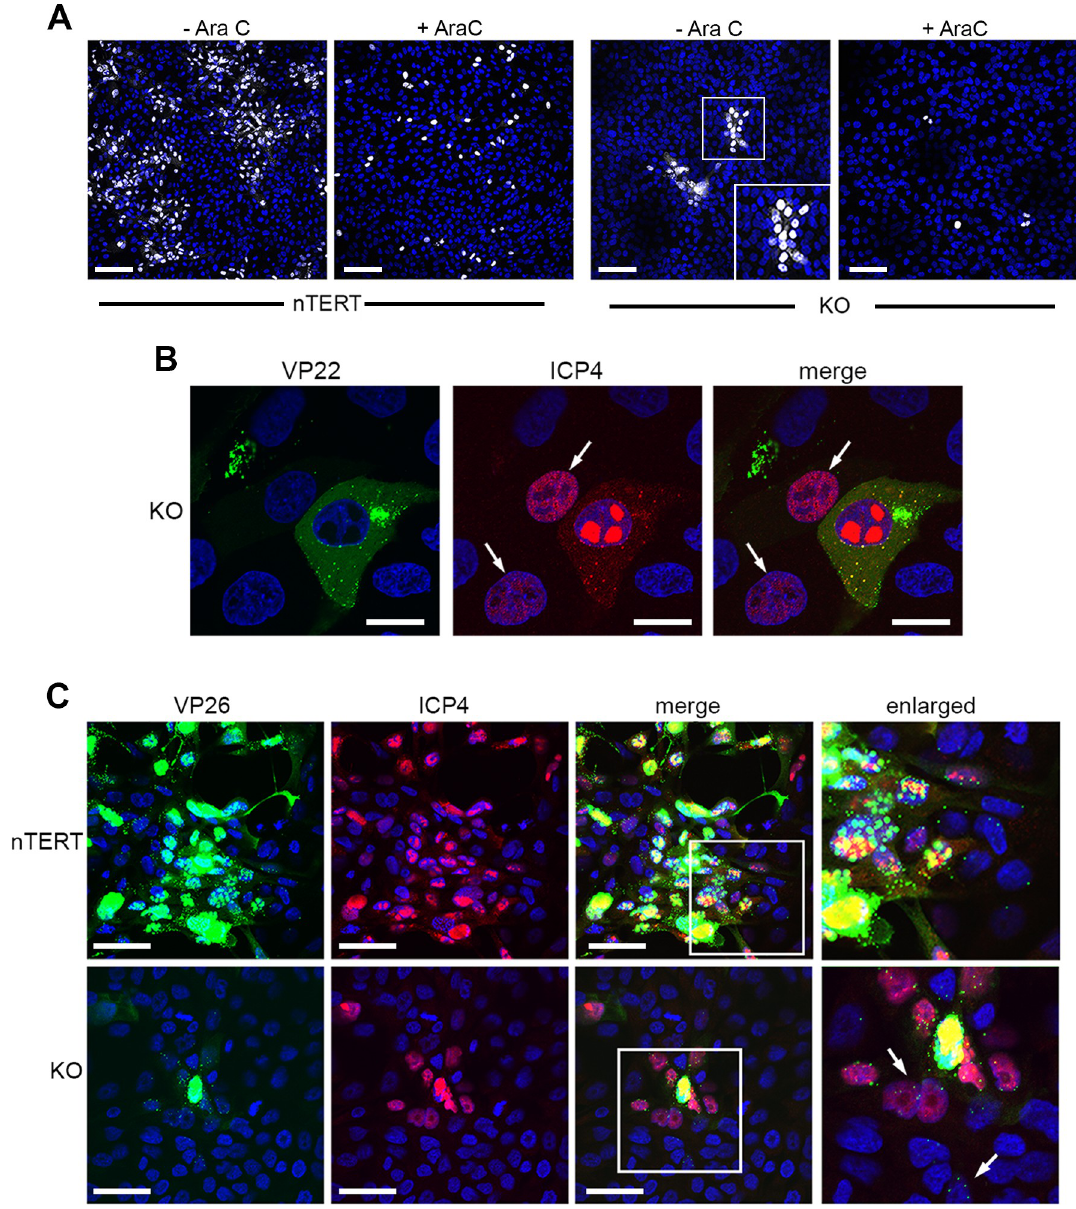
Fig 5. HSV1 infection spreads in nectin 1 KO cells. (A) nTERT and KO cells were infected with HSV1 Sc16 at MOI 0.05 in the absence or presence of 100 ng/ml AraC to block virus genome replication. Cells were fixed at 12 h and stained for ICP4 (white) and nuclei were stained with DAPI (blue). Scale bar = 100 μ m. (B) nTERT and KO cells grown on coverslips were infected with HSV1 GFP22 (green) at MOI 5 and fixed at 8 h. Cells were permeabilised and stained for ICP4 (red) and nuclei were stained with DAPI (blue). Scale bar = 20 μ m. White arrows indicate cells with recent expression of ICP4. (C) nTERT and KO cells grown on coverslips were infected with HSV1 GFP-VP26 at MOI 5 and fixed at 12 h. Cells were permeabilised and stained for ICP4 (red) and nuclei were stained with DAPI (blue). GFP-VP26 is in green. Scale bar = 50 μ m. Arrow points to cells with GFP-tagged capsids next to the original infected